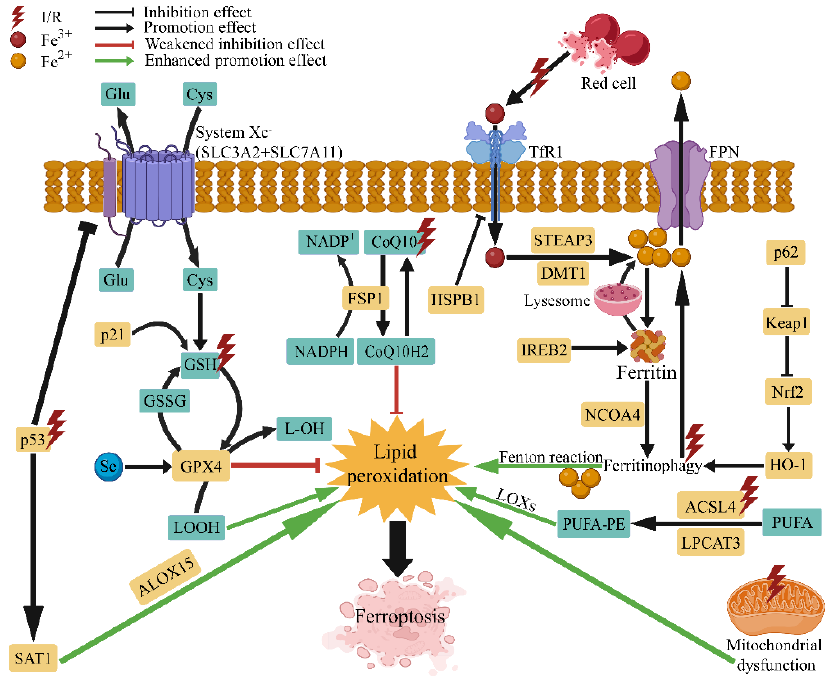
Figure 1. Overview of the regulatory mechanism of ferroptosis in ischemia-reperfusion. I/R, ischemia-reperfusion; Glu, glutamate; Cys, cystine; SLC3A2, solute carrier family 3 member 2; SLC7A11, solute carrier family 7 member 11; p21, cyclin dependent kinase inhibitor 1A; p53, protein 53; GSH, glutathione; GSSG, glutathione oxidized; Se, selenium; GPX4, glutathione peroxidase 4; SAT1, spermidine/spermine N1-acetyltransferase 1; ALOX-15, arachidonate lipoxygenase 15; NADPH, nicotinamide adenine dinucleotide phosphate; CoQ10, coenzyme Q10; FSP1, ferroptosis suppressor protein 1; HSPB1, heat shock factor-binding protein 1; TfR1, transferrin receptor 1; FPN, ferroportin; STEAP3, six transmembrane epithelial antigen of the prostate 3; DMT1, divalent metal-ion transporter-1; IREB2, iron response element-binding protein 2; NCOA4, nuclear receptor coactivator 4; LOXs, lipoxygenases; PUFA, polyunsaturated fatty acids; PUFA-PE, polyunsaturated phosphatidylethanolamines; ACSL4, acyl-CoA synthetase long-chain family member 4; LPCAT3, lysophosphatidylcholine acyltransferase 3; HO-1, heme oxygenase 1; Nrf2, nuclear factor erythroid 2-related factor 2; Keap1, kelch-like ECH-associated protein 1; p62, sequestosome 1.